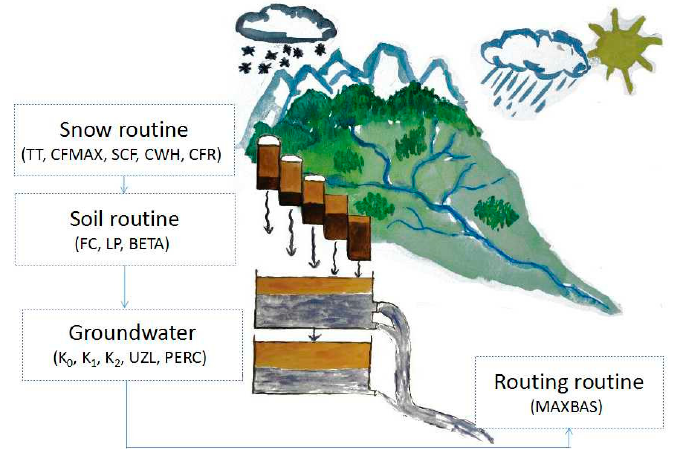
Figure 3. Schematic structure of the HBV (Hydrologiska ByransVattenavdelning) model, version HBV light model (used with permission from [22], originally painted by Petra Seibert).